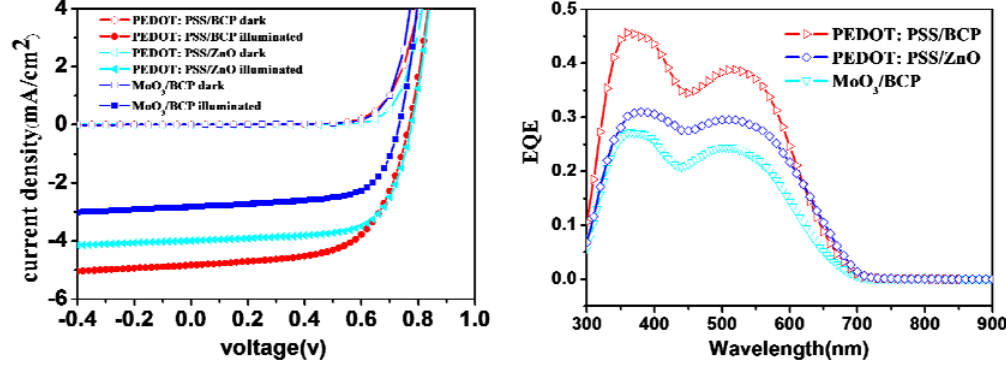
Figure 4. J-V curves and EQE profiles of devices based on a structure of ITO/Hole transport layer/D149 (8 nm)/C (40 or 50 nm)/Electron transport layer/Al (100 nm) with 70 different electron- and hole-transport layers under AM 1.5G illumination or dark